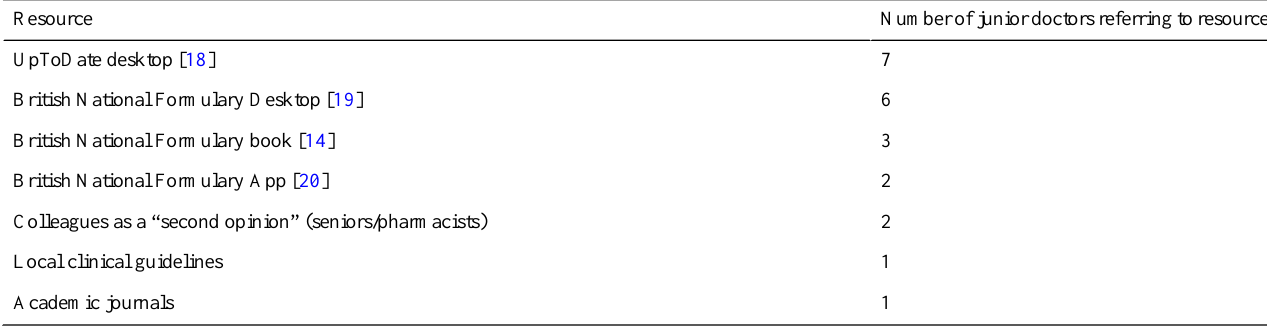
Table 5. Alternative sources of clinical decision support reported by junior doctors in this study.